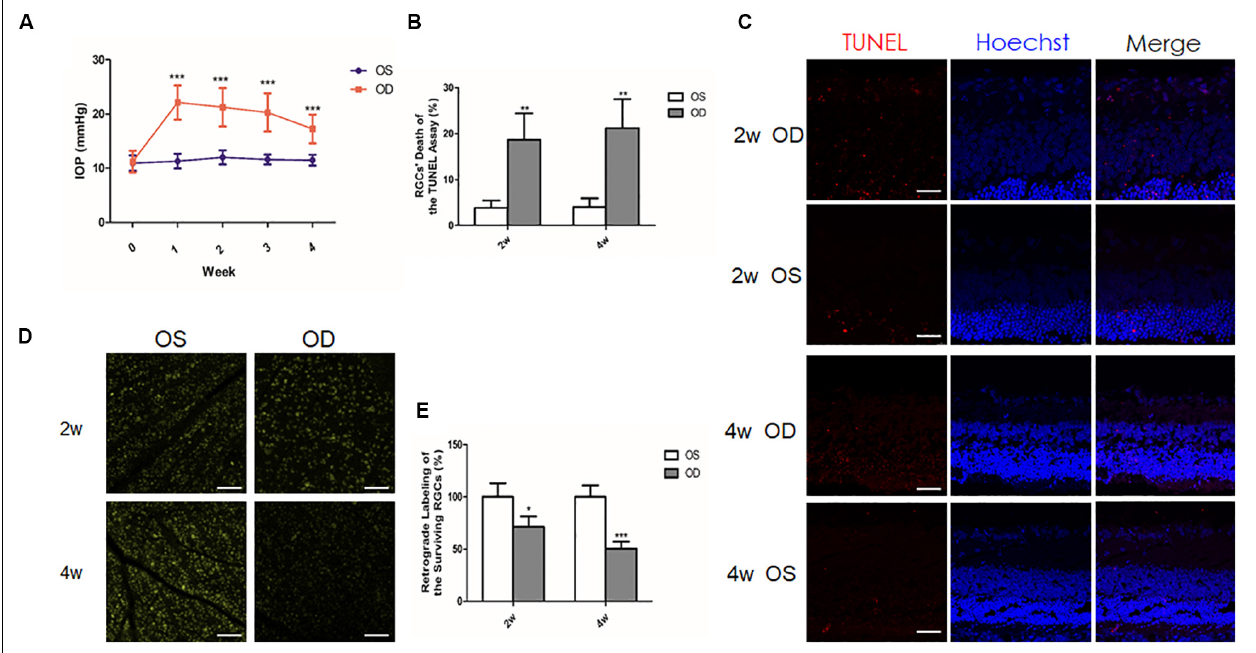
FIGURE 1 | Intraocular pressure (IOP) elevation and retinal ganglion cells (RGCs) change in a chronic ocular hypertension model of rats. (A) Mean IOPs of the hypertensive right eyes and the contralateral left eyes after anterior chamber injection of 0.3% carbomer solution. (B) Quantitative analysis of the percentage of the apoptotic RGCs of the terminal deoxynucleotidyl transferase-mediated dUTP nick-end labeling (TUNEL) assay. (C) TUNEL assay showed increased apoptotic ( red ) RGCs in the hypertensive right eyes ( OD ) when compared to the contralateral left eyes ( OS ; n = 4 for each group). Nuclei were stained with Hoechst ( blue ). (D) Retrograde labeling of the surviving RGCs revealed less RGCs in the hypertensive right eyes than in the left eyes ( n = 5 for each group). (E) Quantitative analysis of retrograde labeling. Data were expressed as the mean ± SD. * P < 0.05; **0.001 < P < 0.01; and *** P < 0.001. Scale bar , 50 µ m.